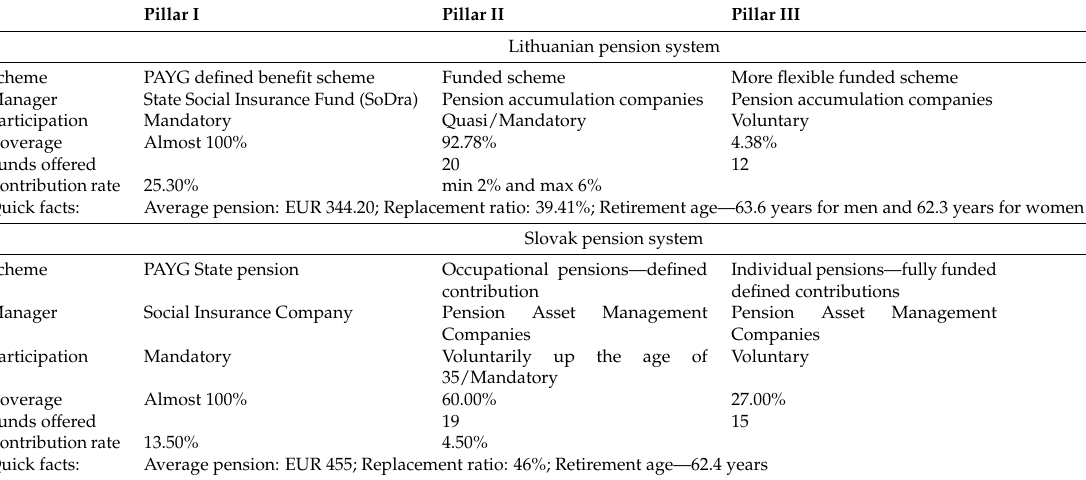
Table 1. Comparison of Lithuanian and Slovak pension systems (cut-off year 2018).